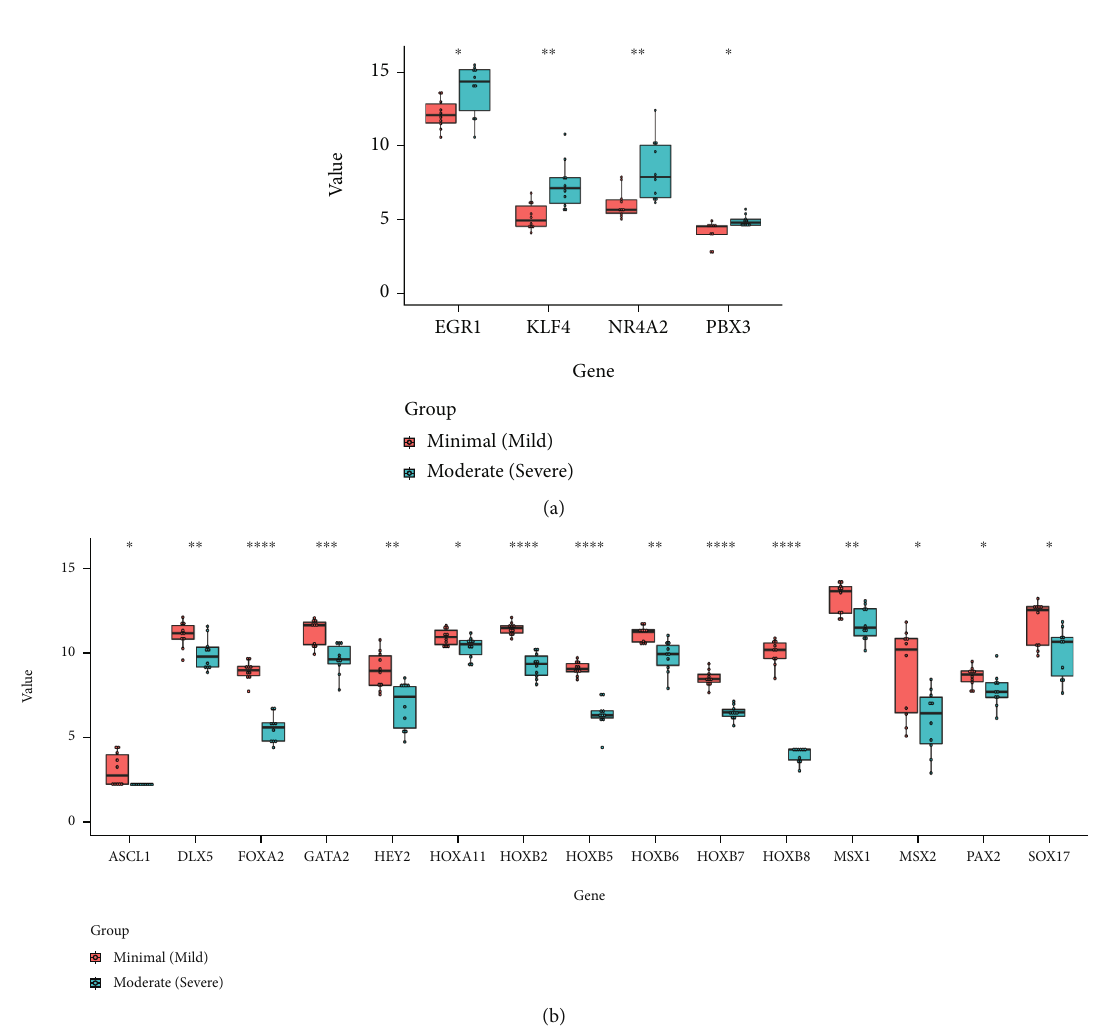
Figure 7: Expression of DETFs in di ff erent severity groups of endometriosis. (a) Upregulated DETFs were highly expressed in moderate/ severe group. (b) Downregulated DETFs were decreased in the moderate/severe group (Unpaired Student ’ s t test was used to compare two groups. ∗ P < 0 : 05 ; ∗∗ P < 0 : 01 ; ∗∗∗ P < 0 : 001 ; ∗∗∗∗ P < 0 : 0001